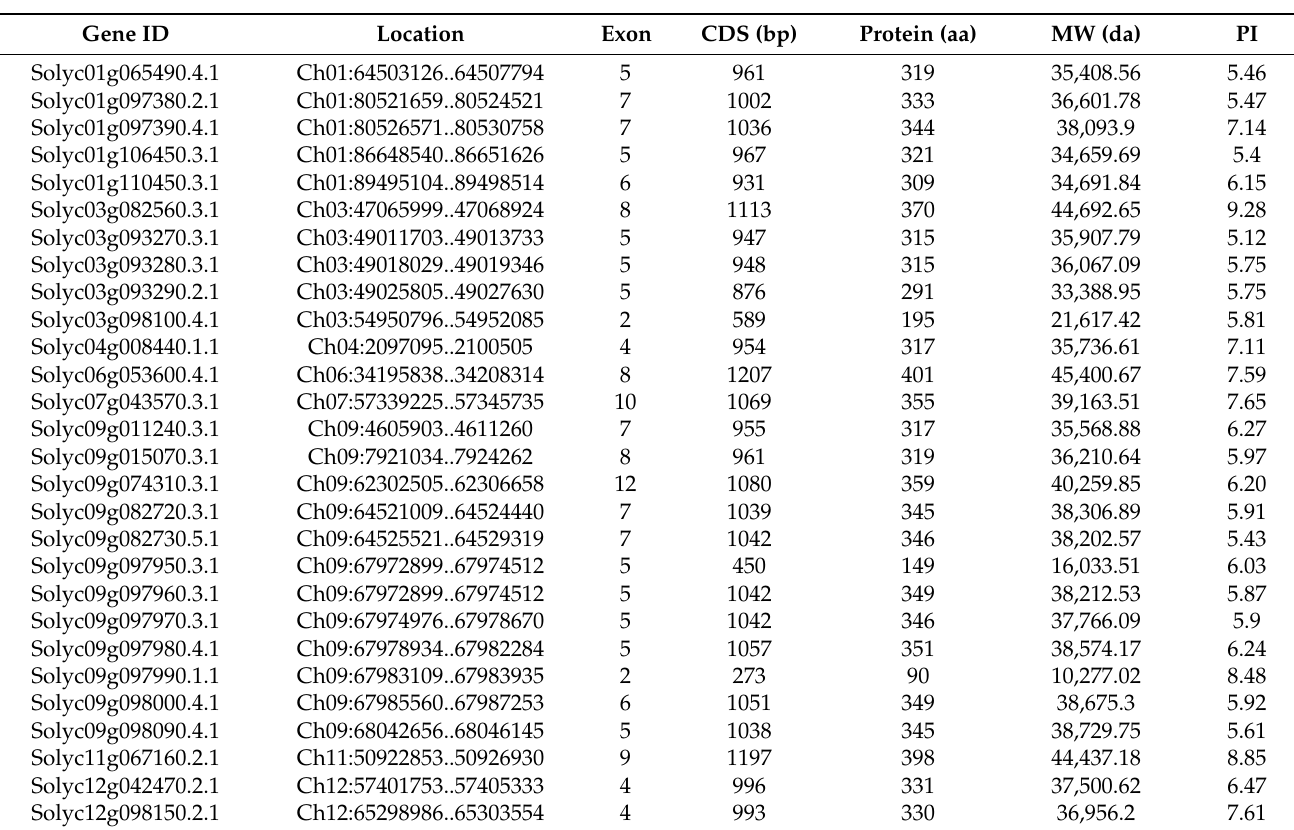
Table 1. The AKR family genes in Solanum lycopersicum